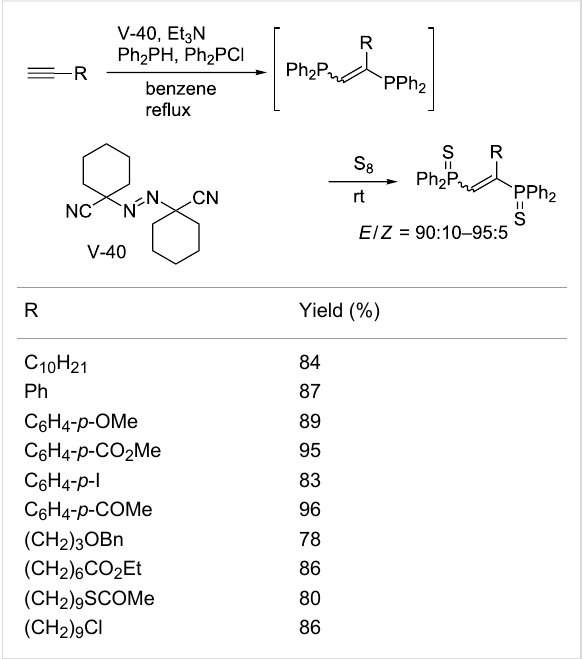
Table 1: Radical anti -selective diphosphination of terminal alkynes.